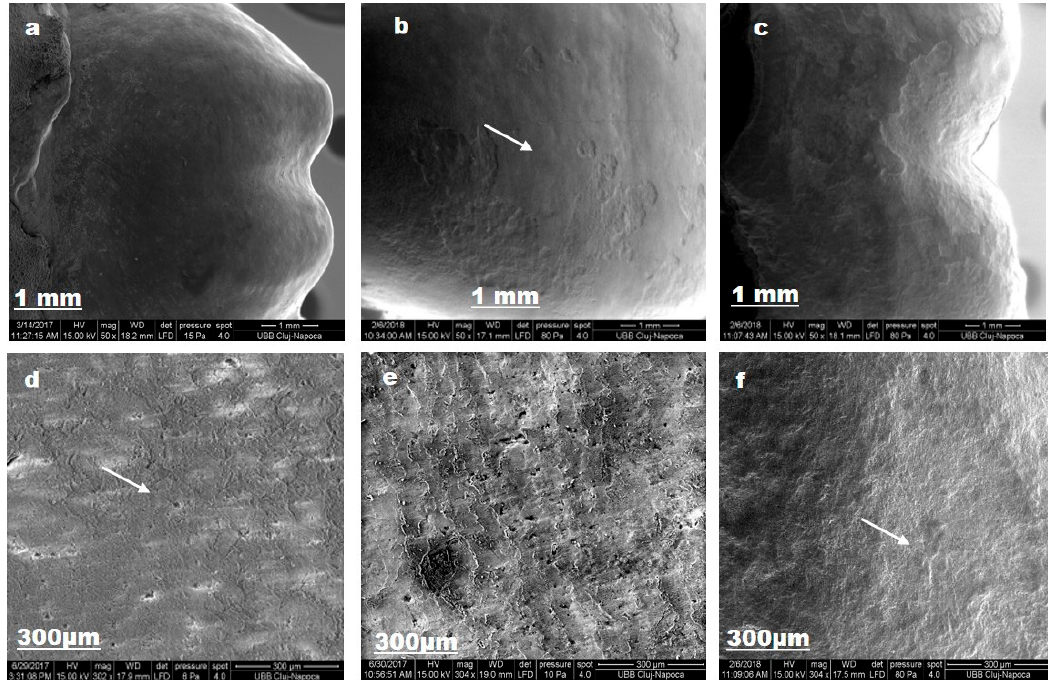
Figure 6. Lacalut_es SEM images for sound enamel after T1 ( a , d ), demineralized enamel surface T2 ( b , e ), enamel surface after T3 ( c , f ).